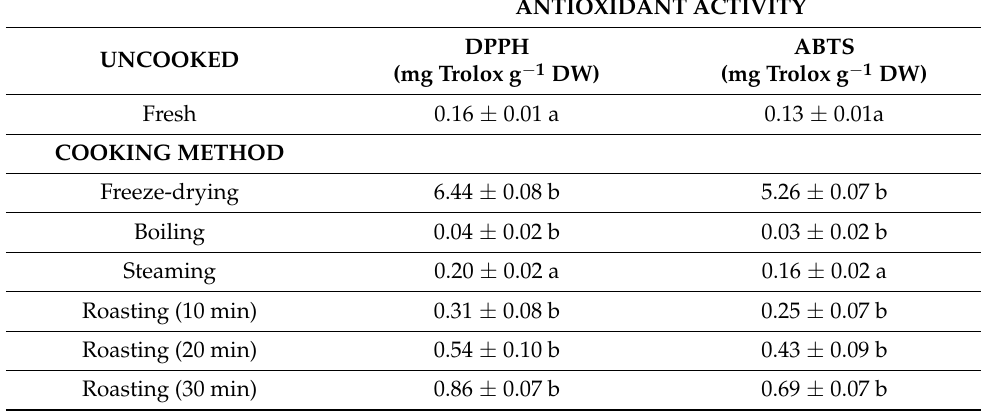
Table 4. Effect of cooking on antioxidant activity. Different lowercase letters between the sample subjected to each cooking method and fresh carrots (used as a reference) indicate differences at p <